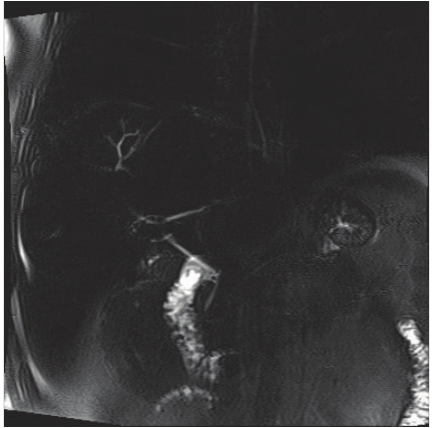
Figure 5: MRCP significant for right intrahepatic